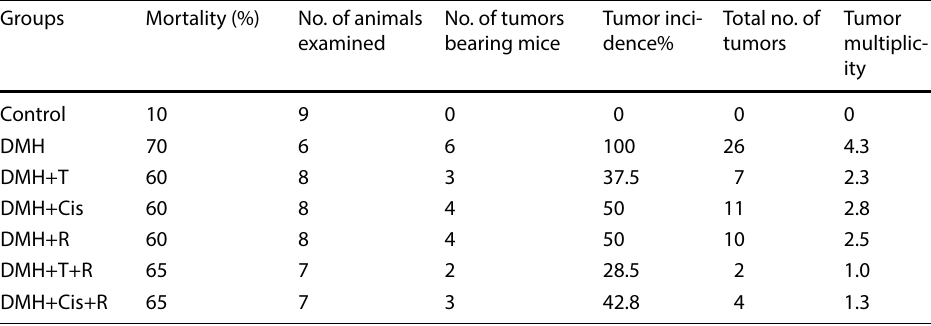
Tumor incidence% = (number of tumor bearing mice/total number of mice)*100. Multiplicity = total num- ber of tumors/total number of mice bearing tumors. Abbreviations; DMH: dimethylhydrazine, T: thiophene derivative, Cis: cisplatin, R: